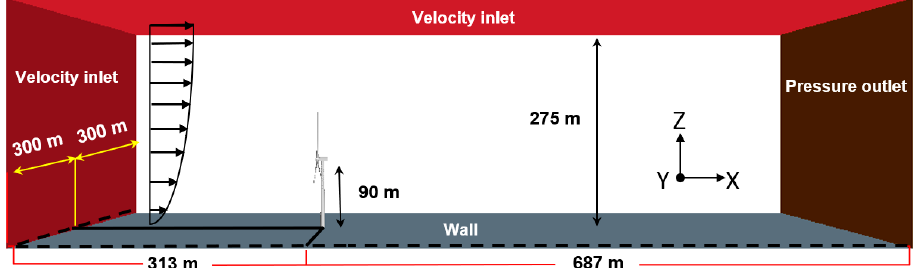
Figure 6. Onshore 5 MW wind turbine fluid domain and boundary conditions.